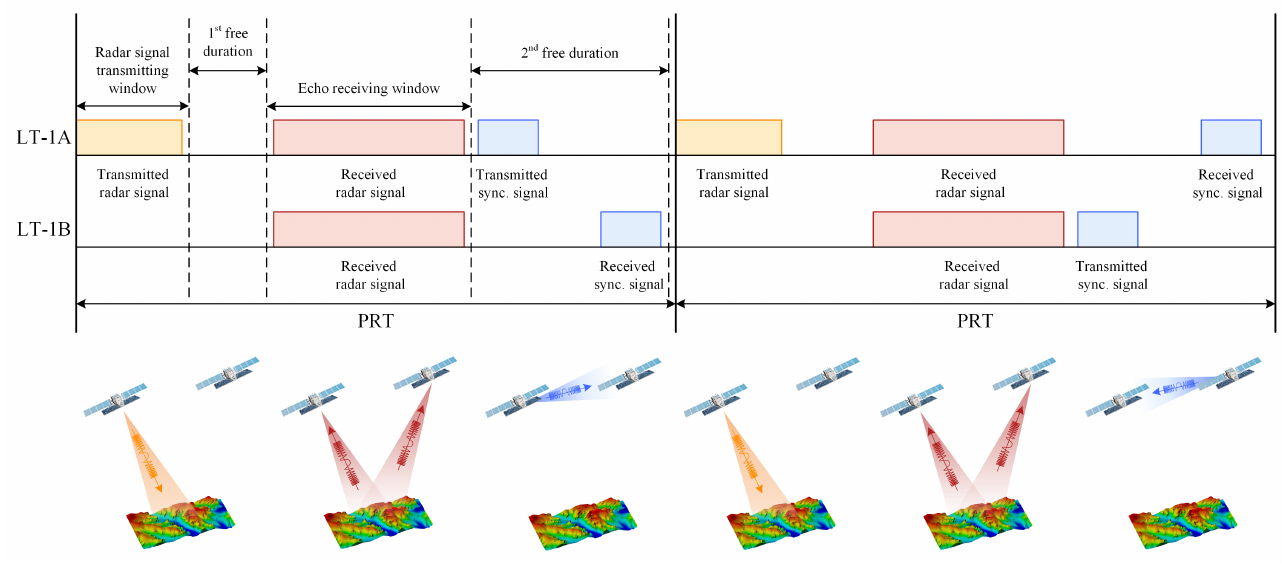
Figure 1. Timing diagram of synchronization pulse